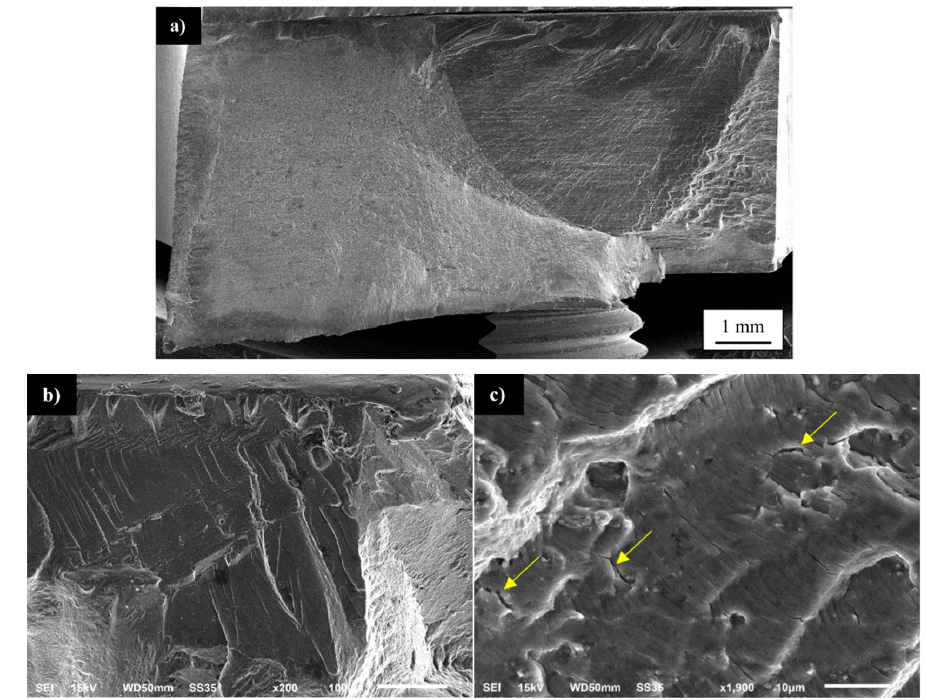
Figure 16. SEM images of fatigue surfaces of a specimen tested at a strain amplitude of 0.35%: ( a ) overall view of the fracture surface, ( b ) magnified view of the crack initiation zone, and ( c ) propagation region near the initiation site. The yellow arrows indicate the secondary cracks.